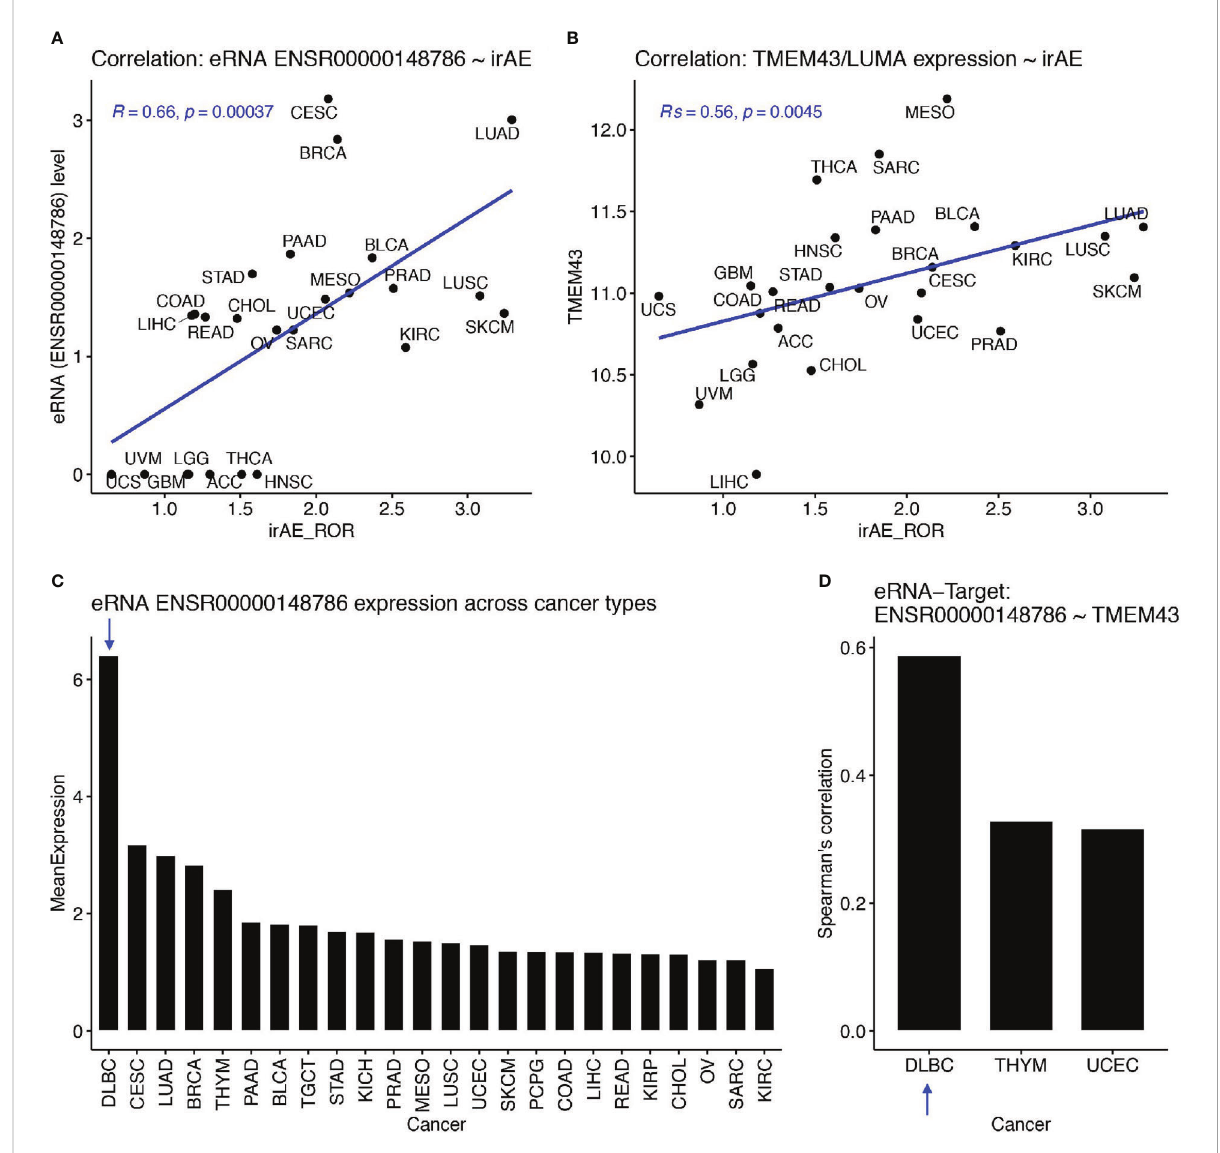
FIGURE 3 The ENSR00000148786 putative target TMEM43/LUMA potentially induced irAE from B cells. (A, B) Signi fi cant correlation between irAE and expression levels of eRNA ENSR00000148786 (A) or TMEM43/LUMA (B, C) Sorted mean expression levels of eRNA ENSR00000148786 across cancer types, with the arrow indicating the highest expression in DLBC (diffuse large B-cell lymphoma). (D) Signi fi cant eRNA-target correlation between ENSR00000148786 and TMEM43/LUMA was the highest in DLBC among the three signi fi cant cancer